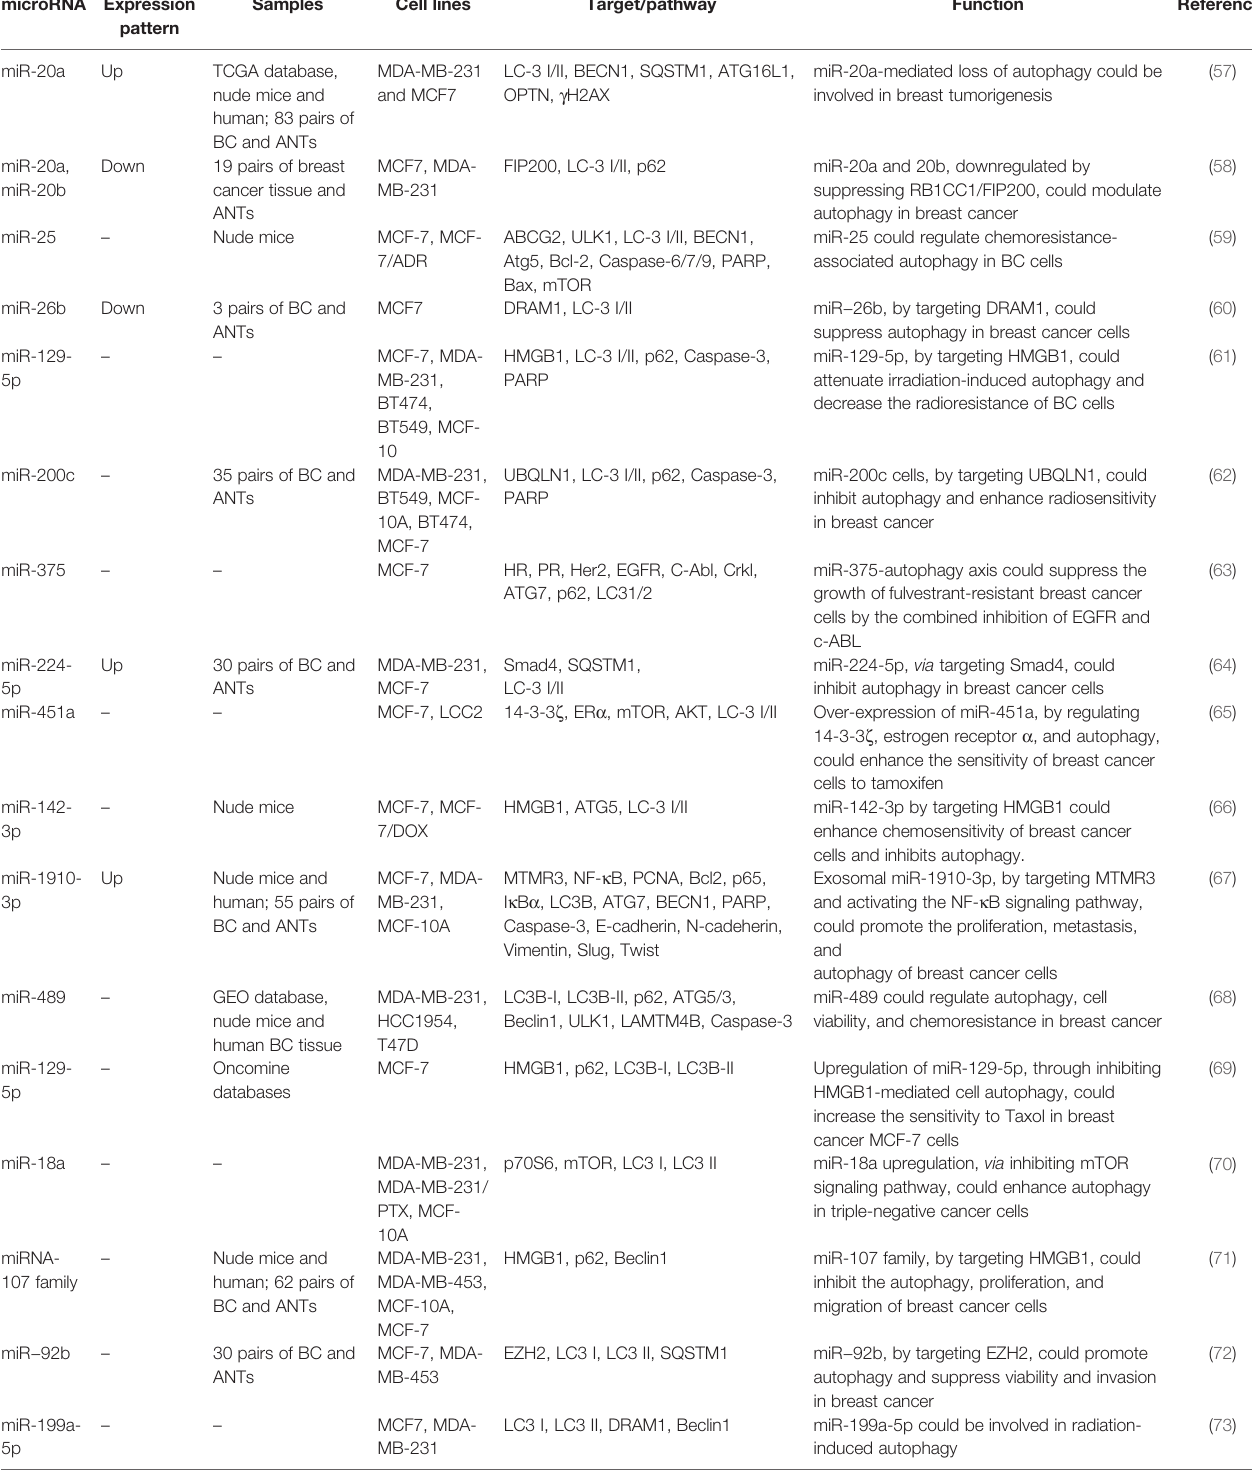
TABLE 2 | Regulation of autophagy by miRNAs in breast cancer. microRNA Expression